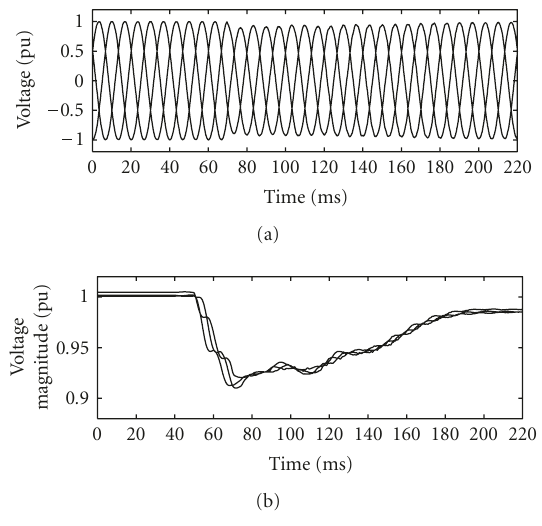
Figure 4: Induction motor starting: (a) voltage waveforms; (b) volt- age magnitude (measurement in a 400V